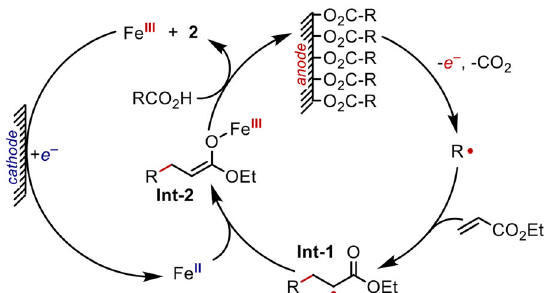
Fig. 6 Proposed mechanism. Illustration of a possible mechanism supported by the data that involves redox at